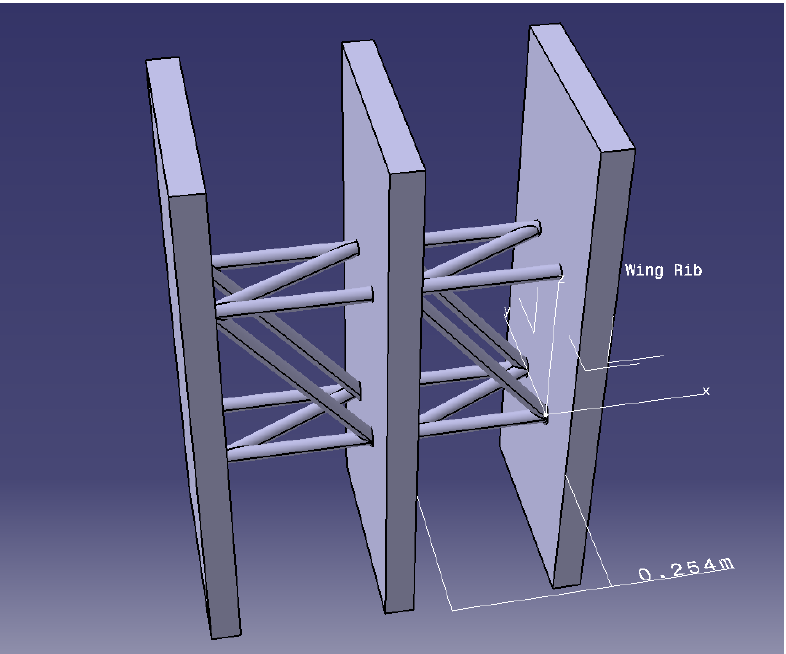
Figure 4. Configuration of structural element connections in morphing wing, Topology 2.